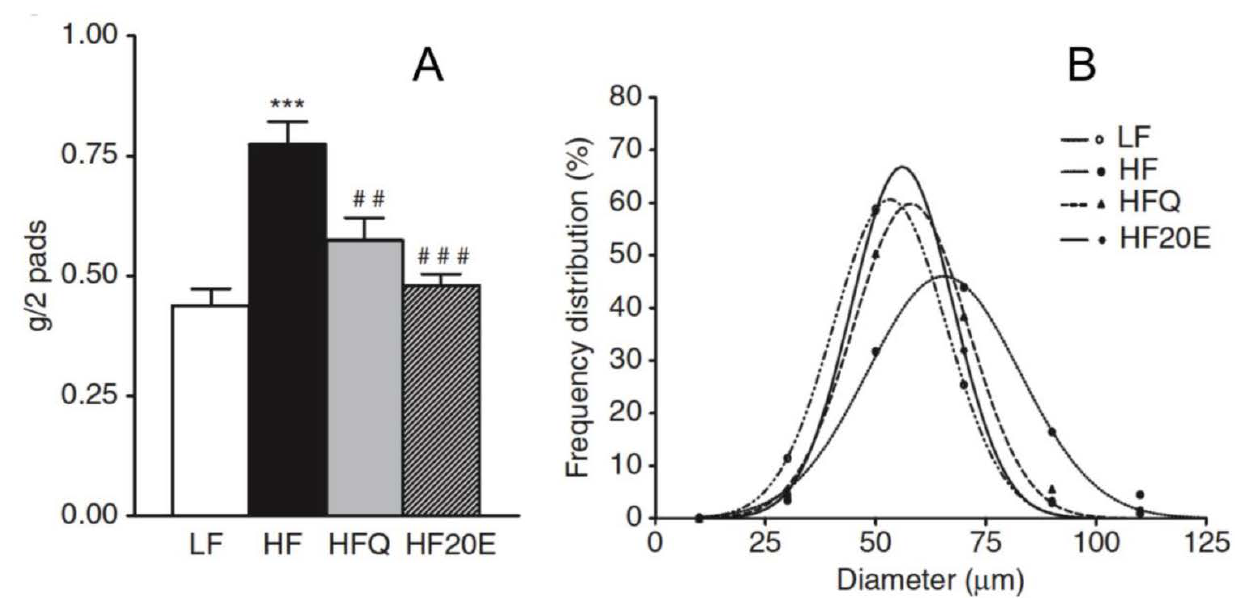
Figure 4. Effect of 20E on mice fed a high-fat diet (HF), when compared to mice fed a low-fat diet (LF). The animals received either pure 20E (50 mg/kg/day) or the same amount of 20E as a quinoa extract (Q). Panel ( A ) shows the impact on the mass of epididymal adipose tissue (*** p < 0.01 when compared to LF; ## p < 0.01 and ### p < 0.001 when compared to HF) and panel ( B ) shows the effect on adipocyte diameter (reproduced, with permission, from